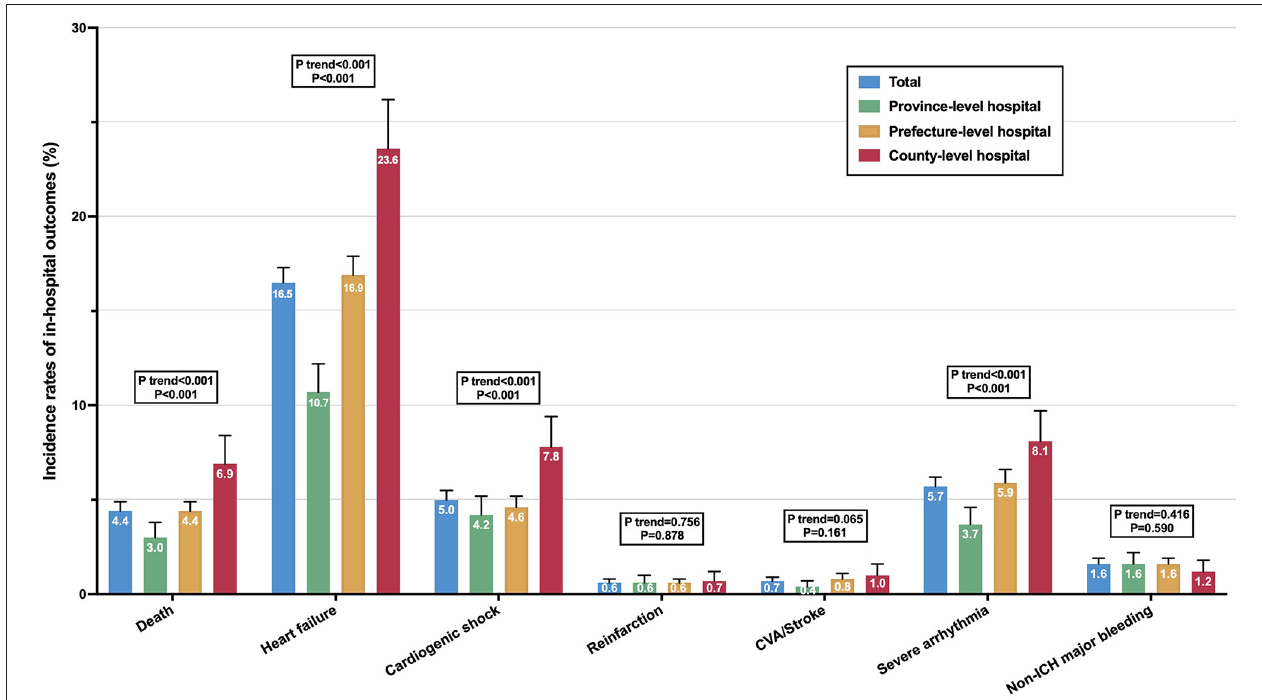
FIGURE 4 | Incidence of in-hospital outcomes in patients with NSTEMI among the three hospital levels in China. The error bars indicate the 95% confidence interval of the sampling